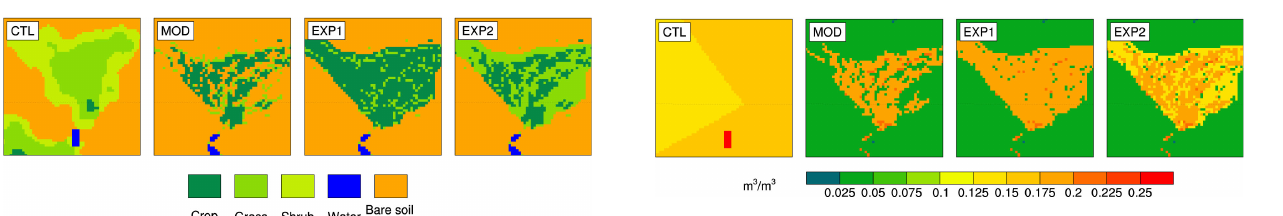
Fig. 3. Distributions of soil moisture at 10-cm depth for the third domain of the four